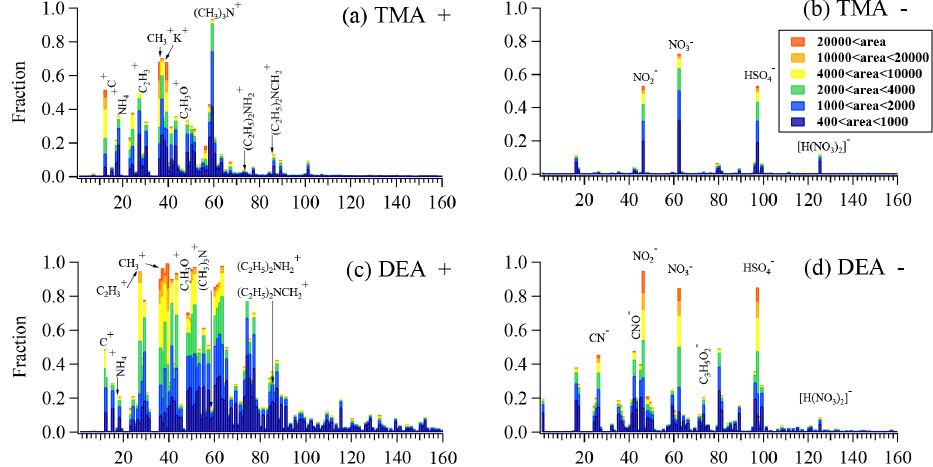
Figure 5. Mass spectra of TMA- and DEA-containing particles during the entire sampling